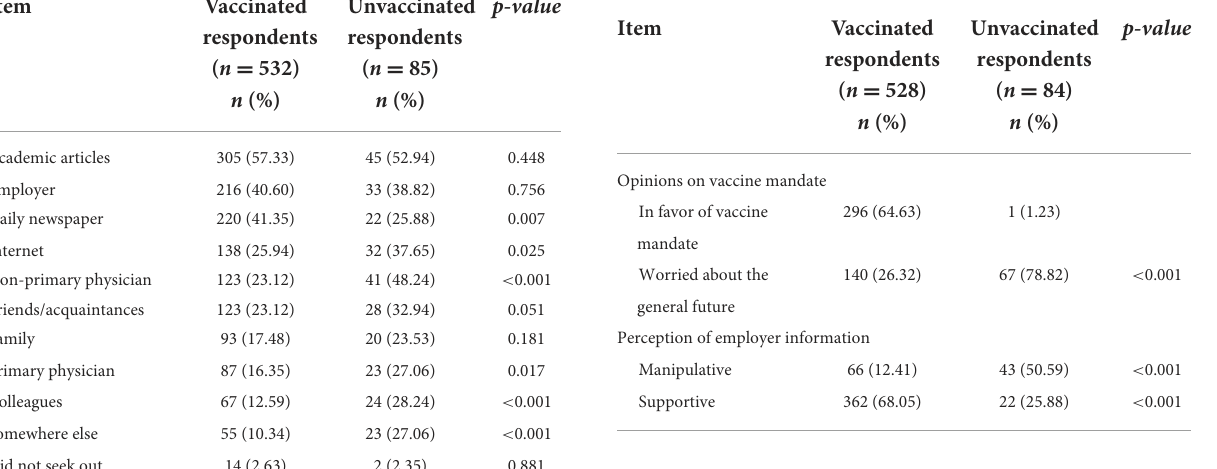
TABLE 3 Sources of information.